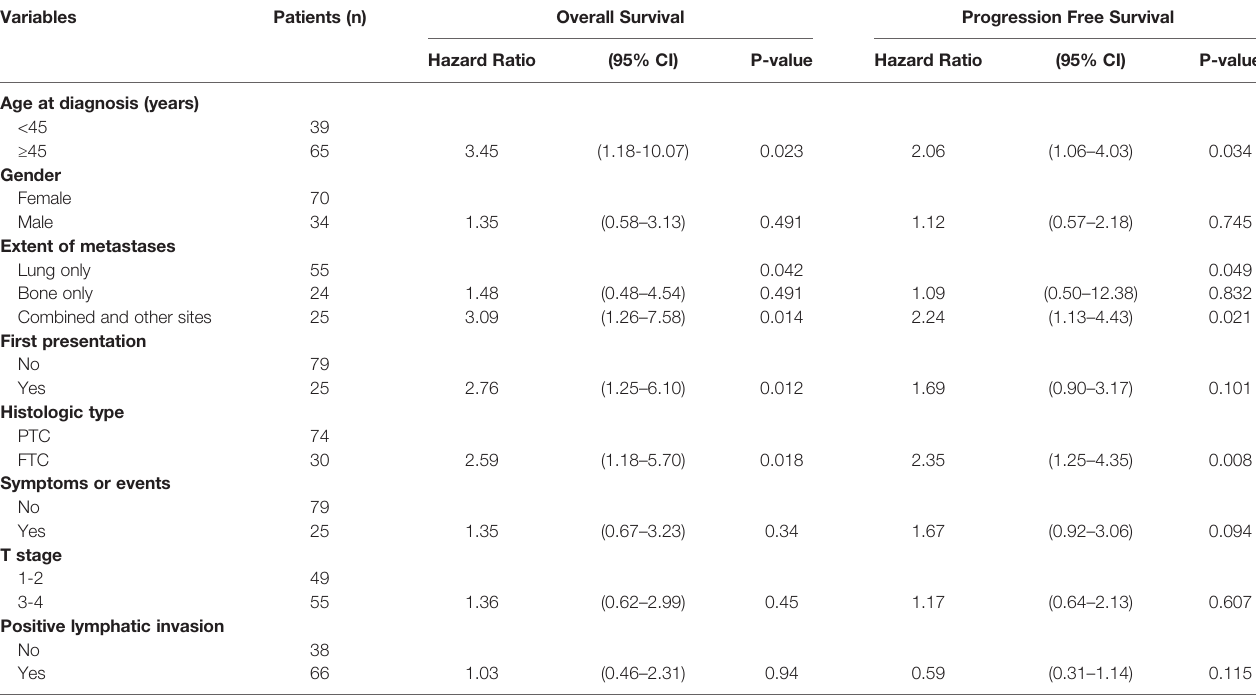
TABLE 1 | Comparison of Overall Survival and Progression Free Survival Based on Clinical Characteristics of dmDTC